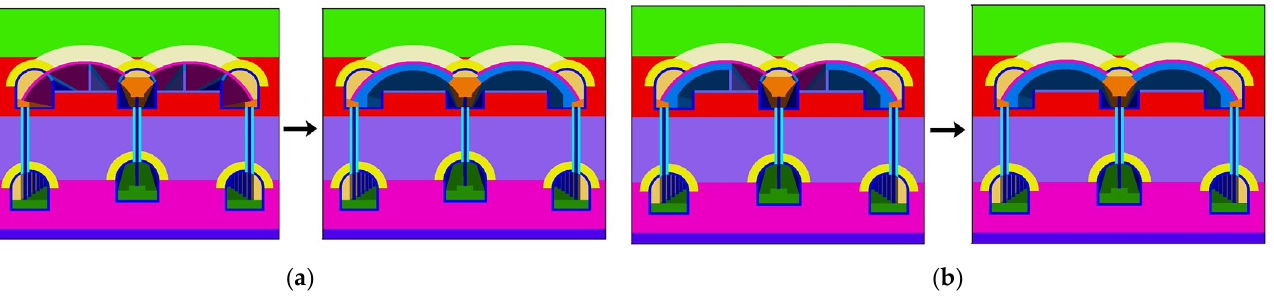
Figure 19. Schematic of different schemes for second lining simulation of arch: Second lining of the arch was completed in ( a ) one attempt and ( b ) two attempts to complete the program simulation.